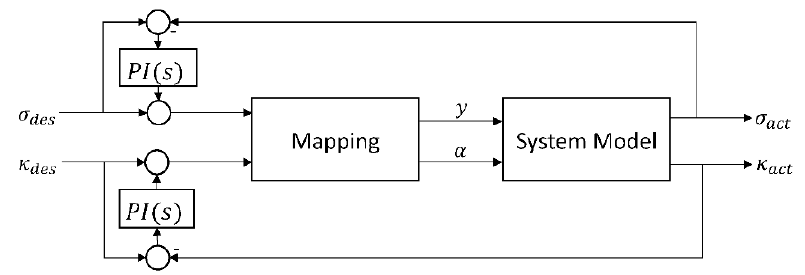
Figure 7. Closed-loop control system structure considering non-tangential bending.